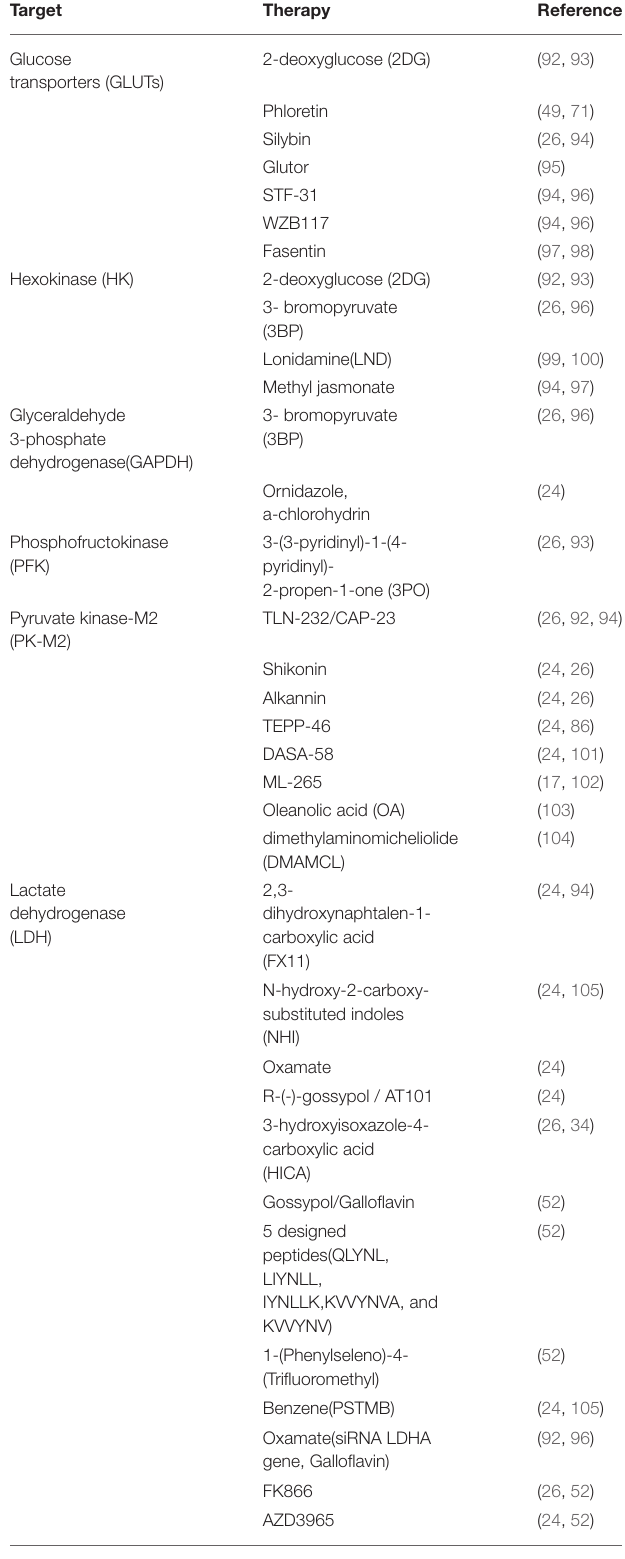
TABLE 1 | Metabolic modulators arising from the metabolic theory of